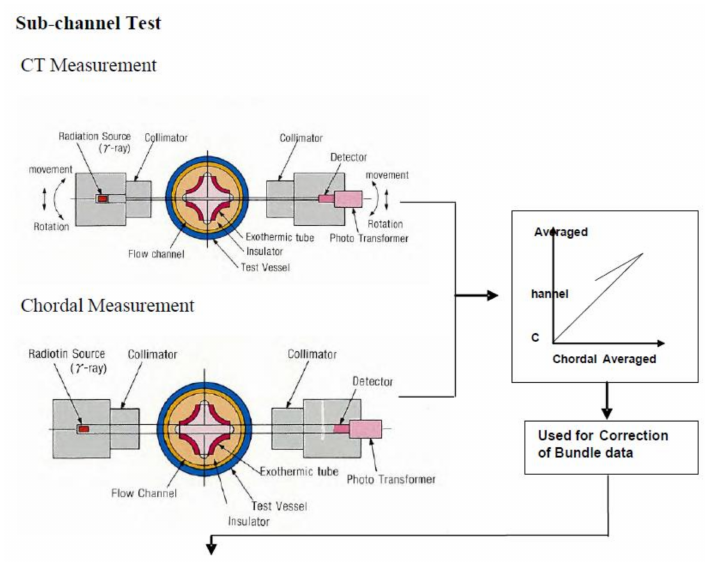
Figure A1. Gamma-ray transmission method (subchannel).